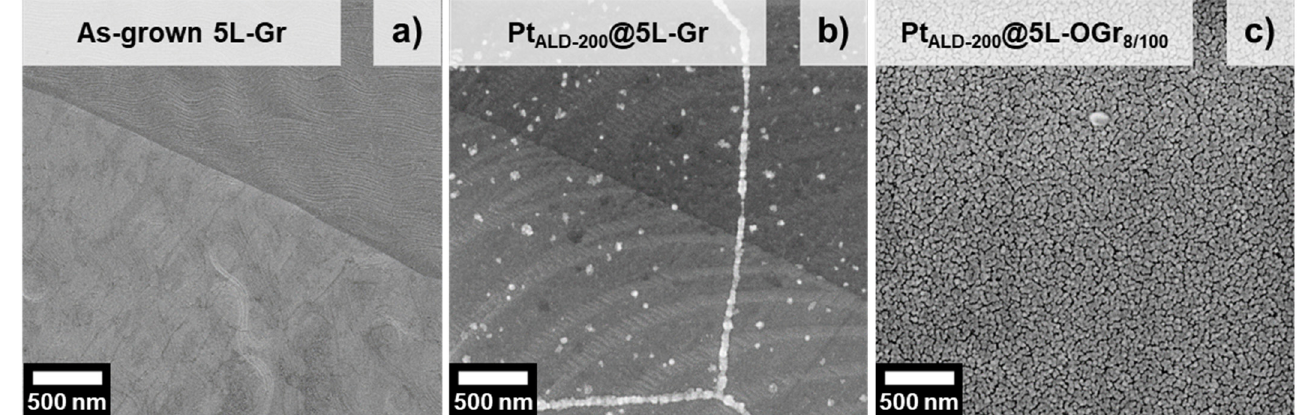
Figure 2. Representative SEM images of 5L-Gr on copper foils. ( a ) As-grown 5L-Gr without modification ( b ) Platinum decorated graphene after 200 ALD cycles (Pt ALD-200 @5L-Gr). ( c ) Oxygen plasma-treated graphene after 200 ALD cycles (Pt ALD-200 @5L-OGr 8/100 ).